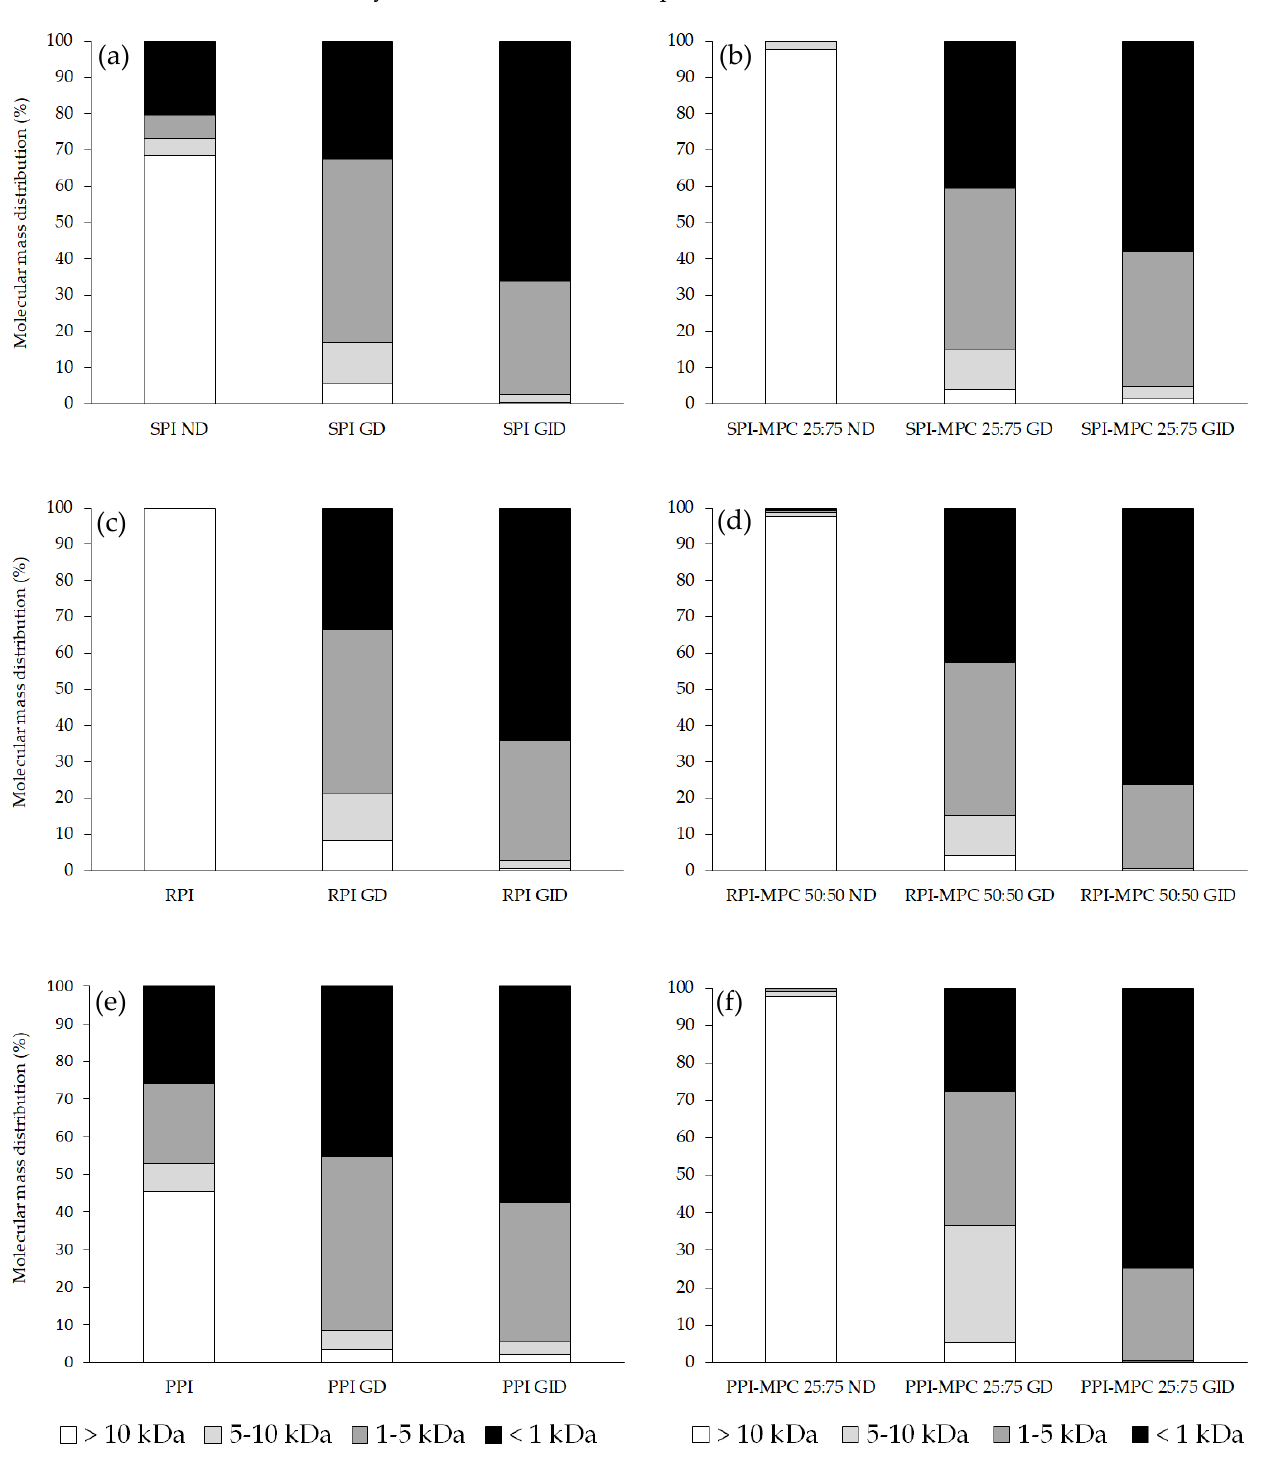
Figure 3. Molecular mass distribution profiles of SPI ( a ) and SPI–MPC 25:75 blend ( b ); RPI ( c ) and RPI–MPC 50:50 blend ( d ); and PPI ( e ) and PPI–MPC 25:75 blend ( f ), before and after simulated gastric and gastro-intestinal digestion. SPI, PPI, RPI and MPC represent soy, pea and rice protein isolate and milk protein concentrate, respectively. ND, GD and GID represent non-, gastro- and gastro-intestinal digested, respectively.